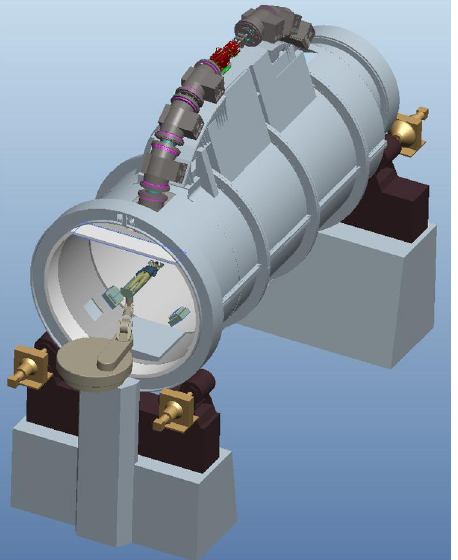
FIG. 1. Three-dimensional image of the superconducting ro- tating gantry for heavy-ion